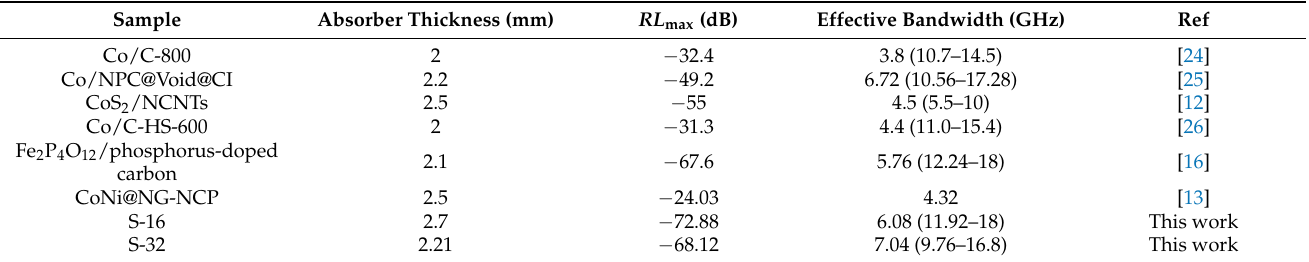
Table 1. Comparison of microwave absorption properties of microwave absorbers in this work with other reported MOF-derived microwave